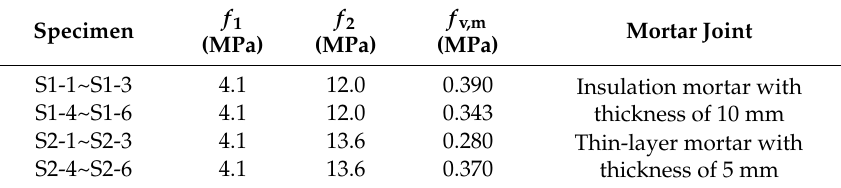
Table 5. Test results of shear strength of self-insulation AAC